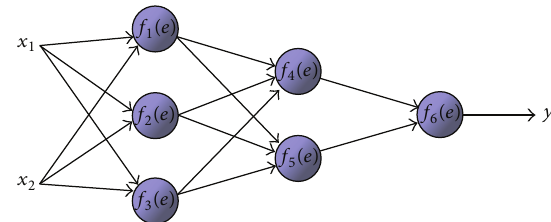
Figure 1: A backpropagation network architecture.